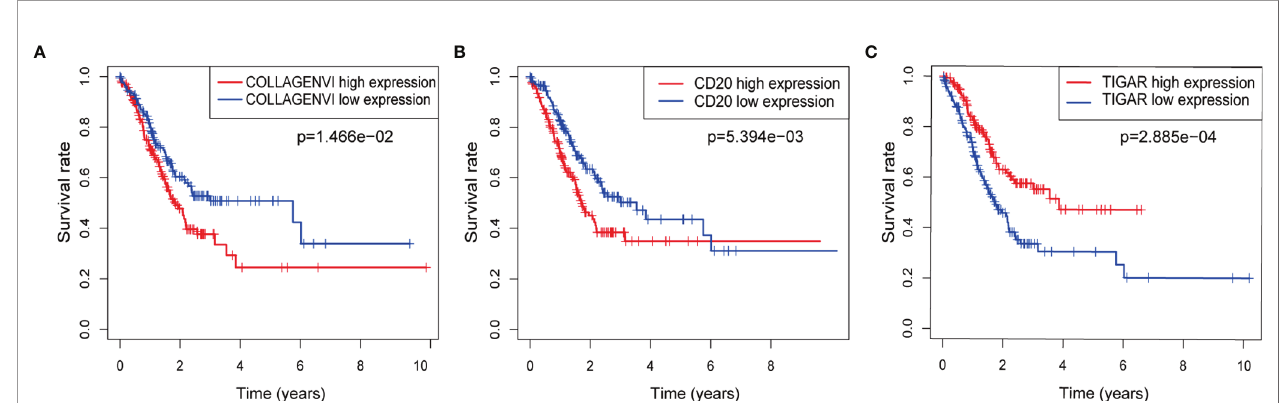
FIGURE 3 | The respective K-M survival prediction curves of the three proteins. (A) COLLAGEN VI; (B) CD20; (C)